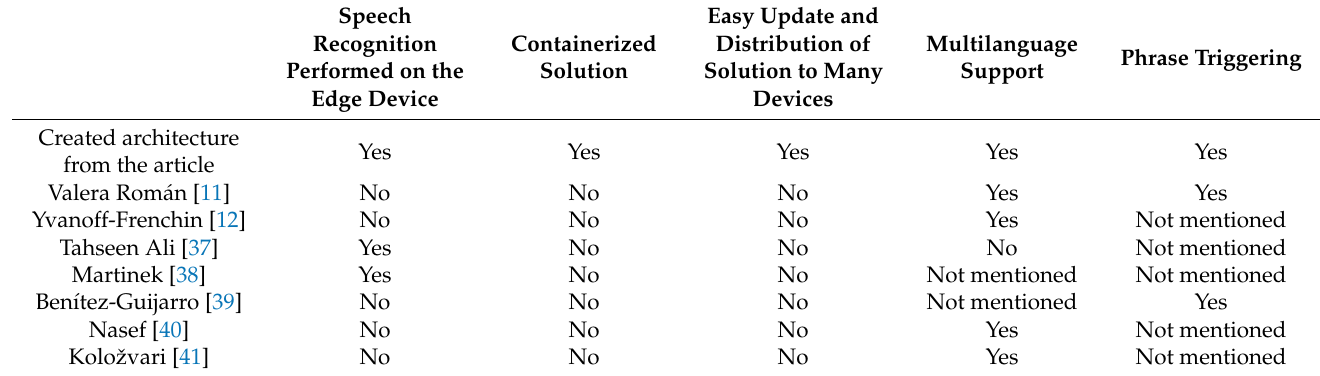
Table 3. Comparison between created architecture and existing